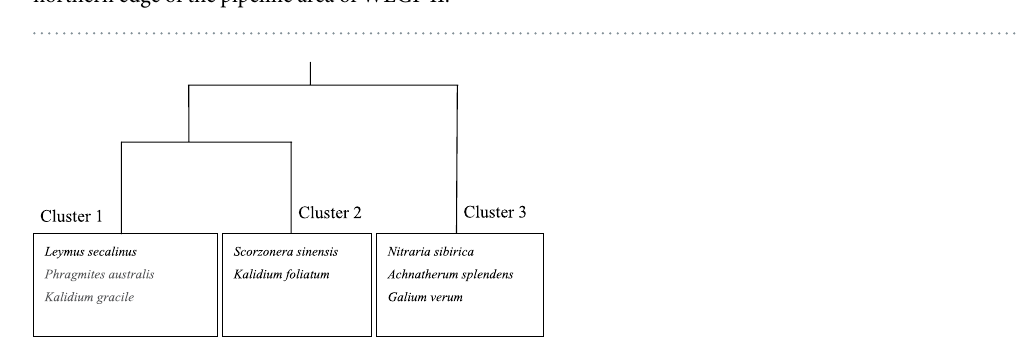
Figure 1. Results of cluster analysis of plant species by